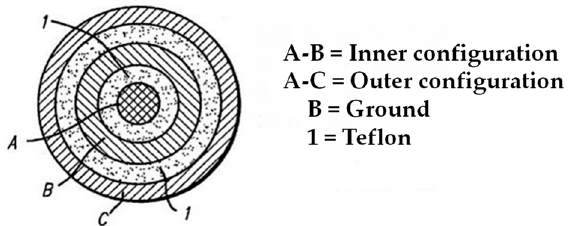
Figure 1. A plane top view of the tip of a probe with two measuring ring electrodes around the central pin electrode. In the inner configuration, the voltage is applied between electrodes A and B, whereas in the outer configuration the voltage is applied between electrodes A and C (with B is acting as a ground).